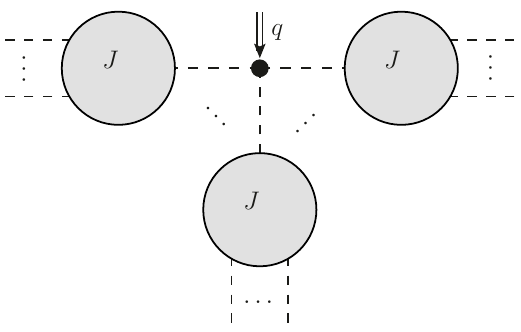
Figure 5 . The remainder function at tree level. The black dot now labels the vertex V created by the current J , while the grey blobs are now semi-on-shell amplitudes J where the only off-shell external leg is connected to V